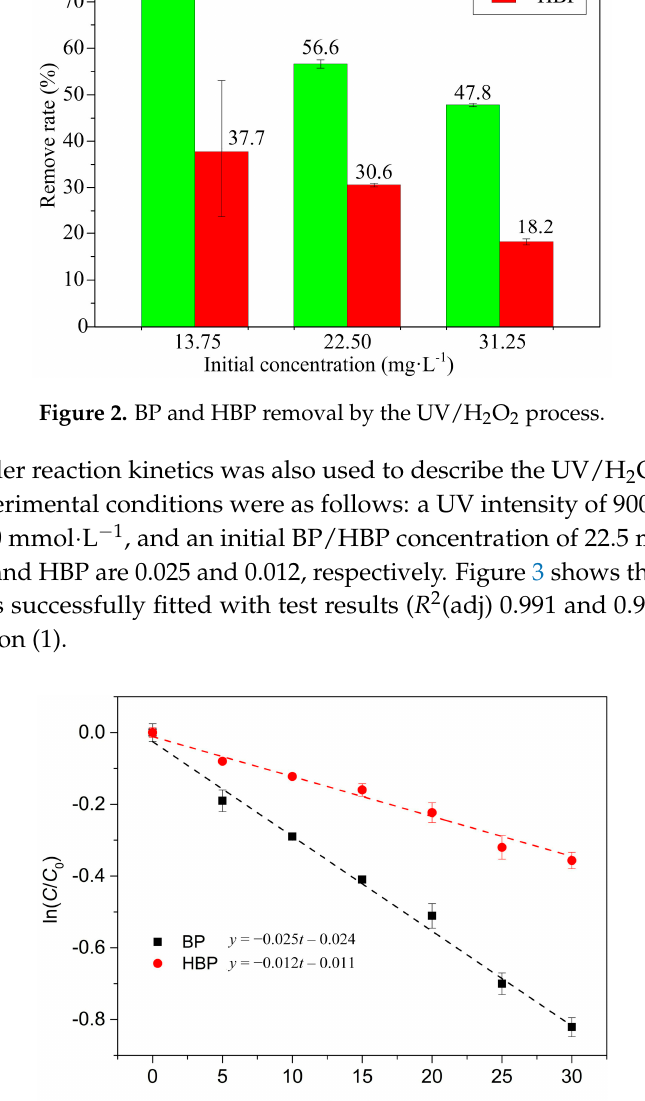
Figure 3. Degradation kinetics of BP and HBP by the UV/H 2 O 2 process.